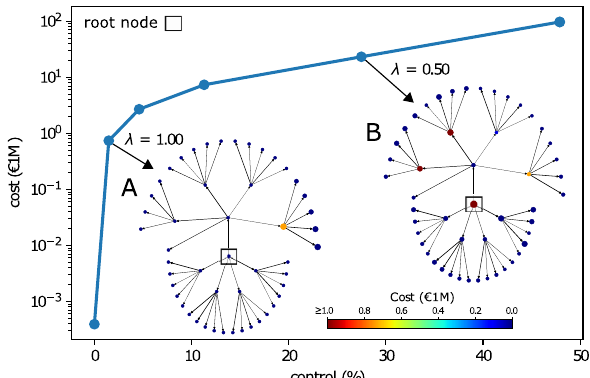
Figure 2. Control and cost loss as a function of (cid:31) -representing the importance of the budget in the control optimization—for the synthetic extended star graph. Control shows the % of total shares of the target nodes that the external agent controls. Cost is the monetary value that the agent spends to acquire a given control (by buying source nodes). The insets A , and B show the intervention strategy of the external agent for (cid:31) = 1 and (cid:31) = 0.5 (in units of control per €1M). The color of the node represents the cost the external agent invests in that specific company, while the size represents the control the external agent